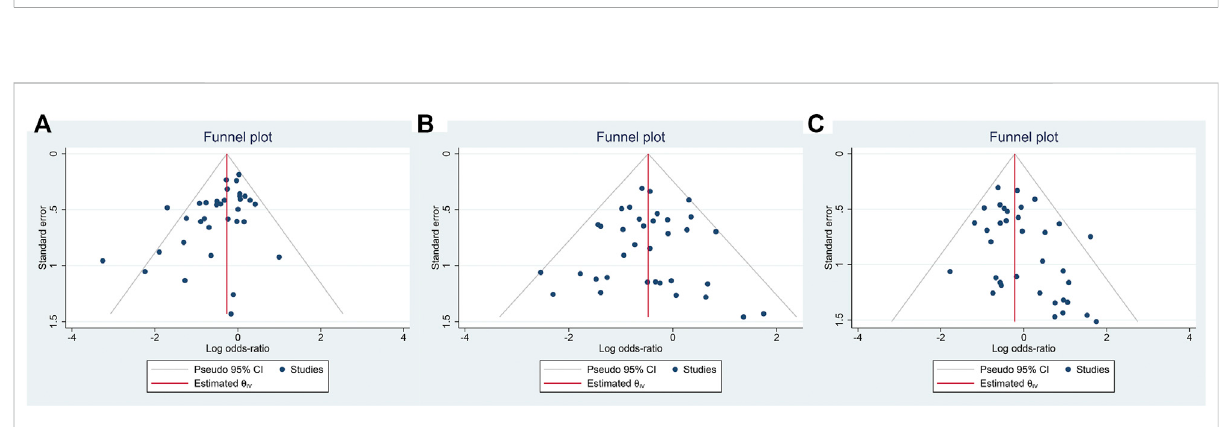
FIGURE 9 (A) Publication bias analysis of EM vs. IM in relation to the H. pylori cure rate in the CYP2C19 genotype (t = − 3.15, p = 0.003). (B) Sensitivity analysisofEMvs.PMinrelationtothe H.pylori curerateintheCYP2C19genotype(t= − 0.34, p =0.737). (C) SensitivityanalysisofIMvs.PMinrelation to the H. pylori cure rate in the CYP2C19 genotype (t = 2.19, p = 0.035). Publication bias, p = 0.05.